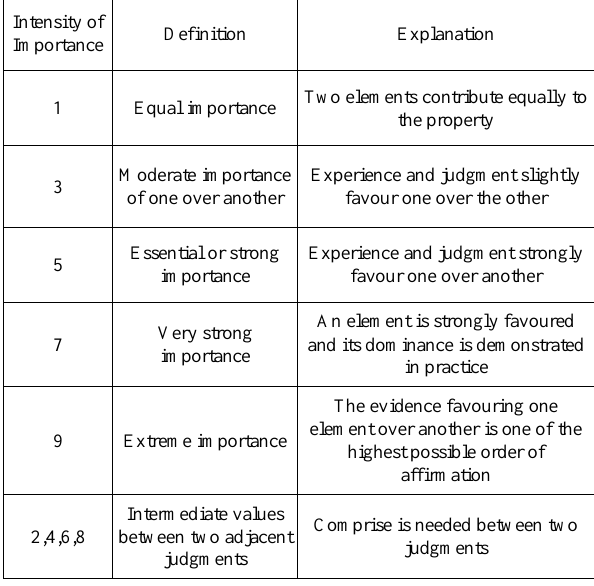
Table 3. Saaty’s Ratio scale for pair wise comparison of importance of weights of